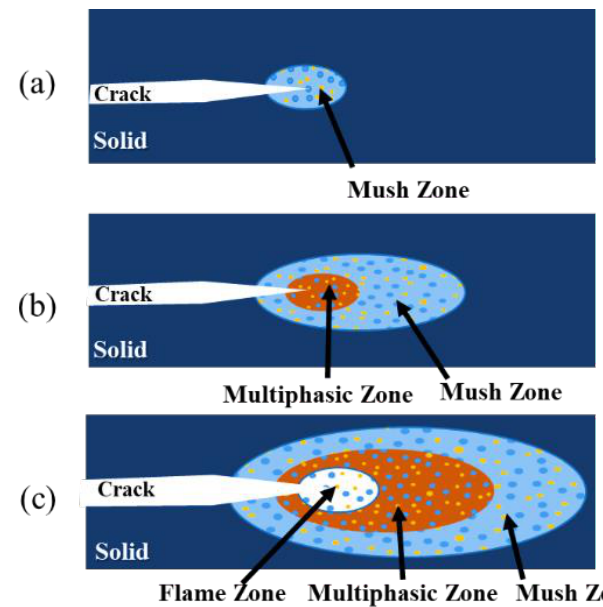
Figure 15. Ignition process of PAB: ( a ) Local PTFE melts to form mush zone; ( b ) Multiphasic zone is formed; ( c ) Flame zone appears.